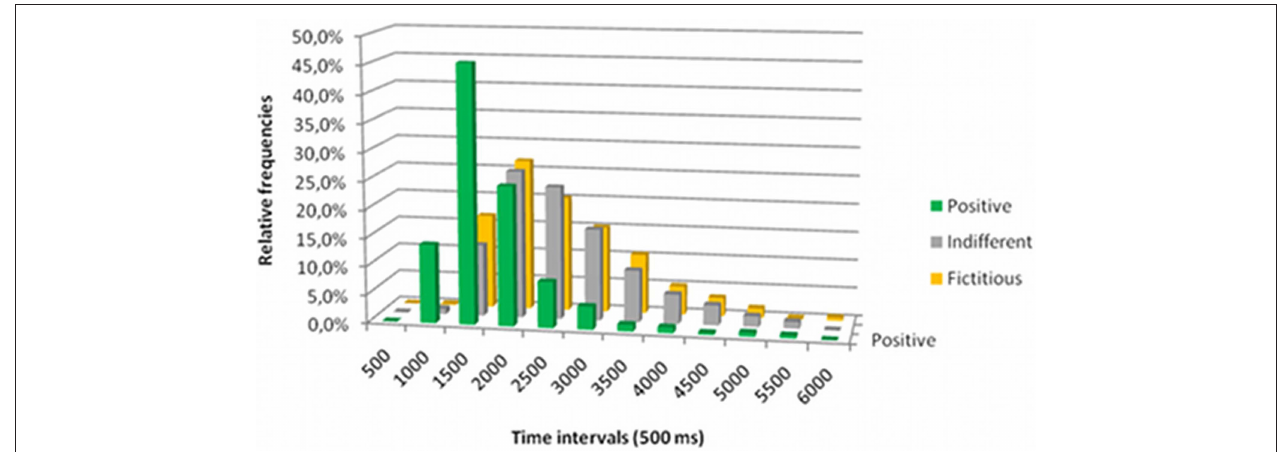
FIguRe 4 | Relative frequency of response times obtained during the scanning session grouped in 500 ms intervals.